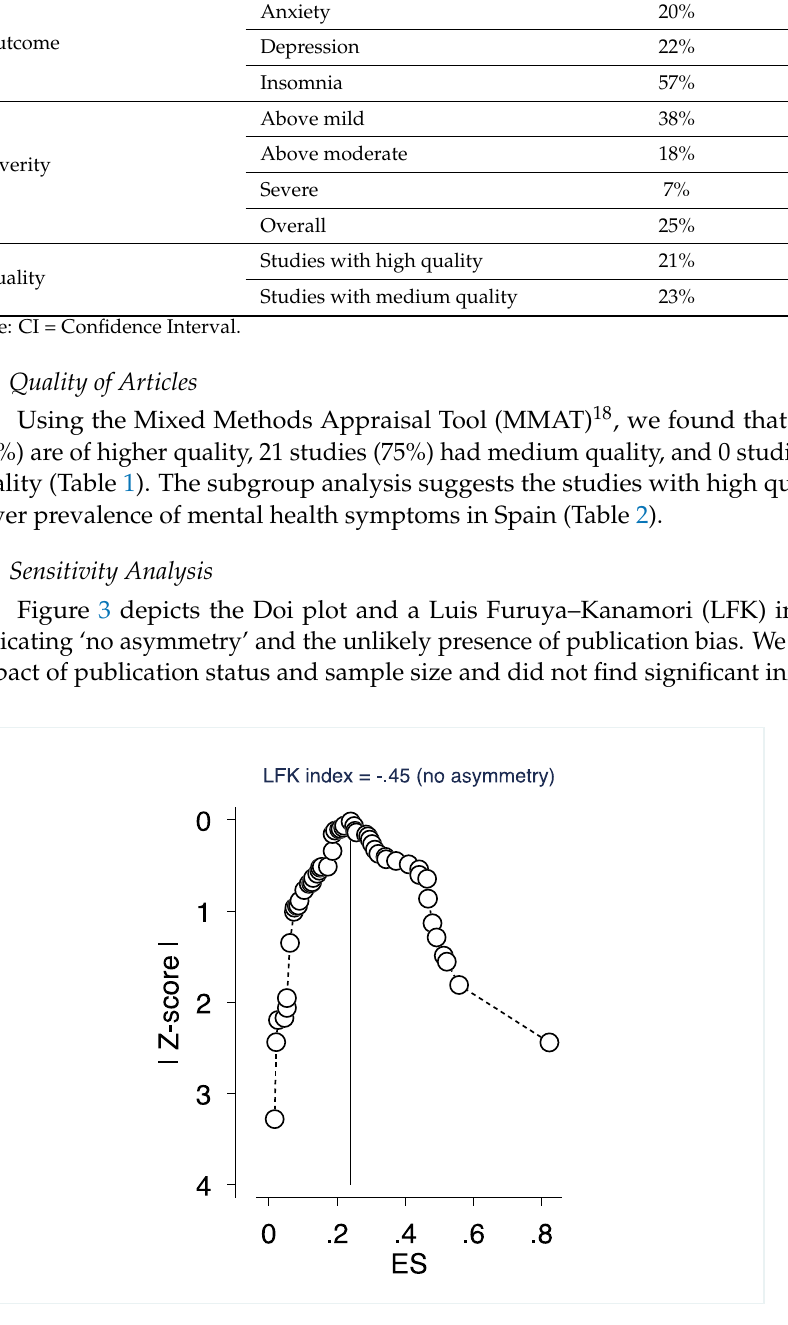
Figure 3. Depiction of publication bias in the baseline meta-analysis of proportion studies based on Doi plot and the Luis Furuya–Kanamori (LFK) index -a score that is within ±1 indicates ‘no asym- metry’.